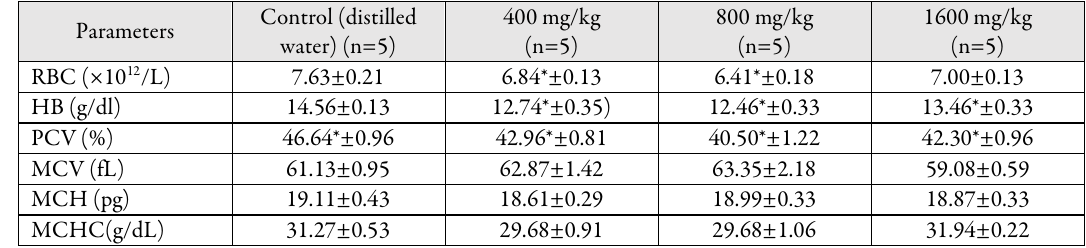
Table 3. The effect of calabash chalk on haemoglobin concentration, packed cell volume, red blood cell and red blood cell indices of Wistar rats